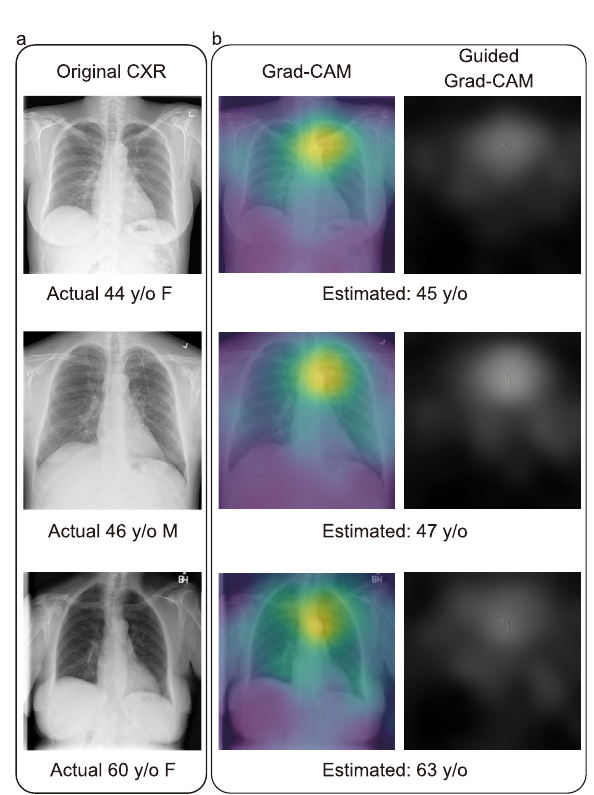
Fig. 3 Visualization of the deep learning model with Grad-CAM and guided backpropagation. Example of original CXRs and heatmap visualization using Grad-CAM and guided Grad-CAM. a Original CXR image in the dataset with chronological age, sex; F, female; M, male; y/o, years. b Visualization of deep learning model using Grad-CAM and a combination of guided backpropagation and the